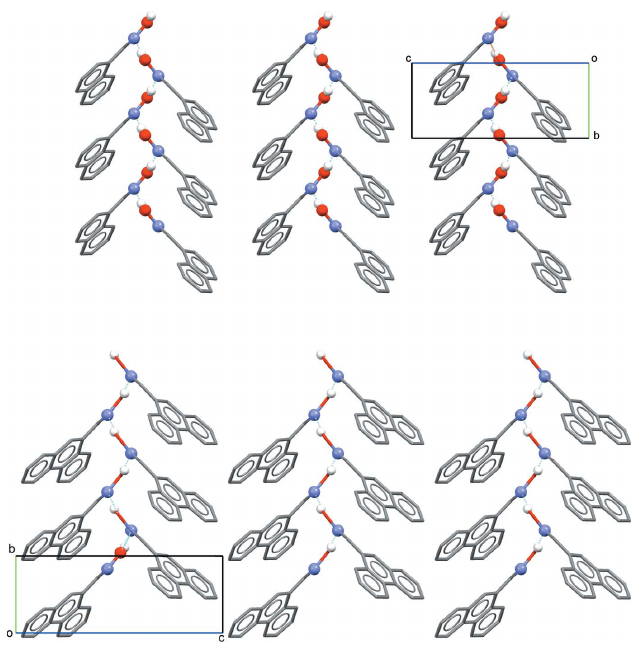
Figure 4 A packing diagram viewed along the a axis for (I) (top) and (II) (bottom), showing polymeric chain